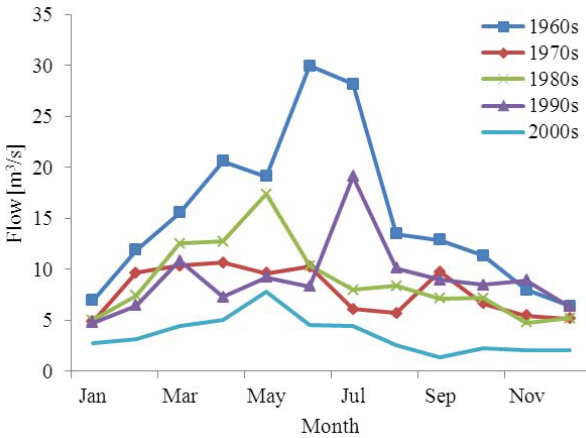
Fig. 2. Monthly flow regime (monthly average flow by each decade) at RRB outlet (source: USGS Station